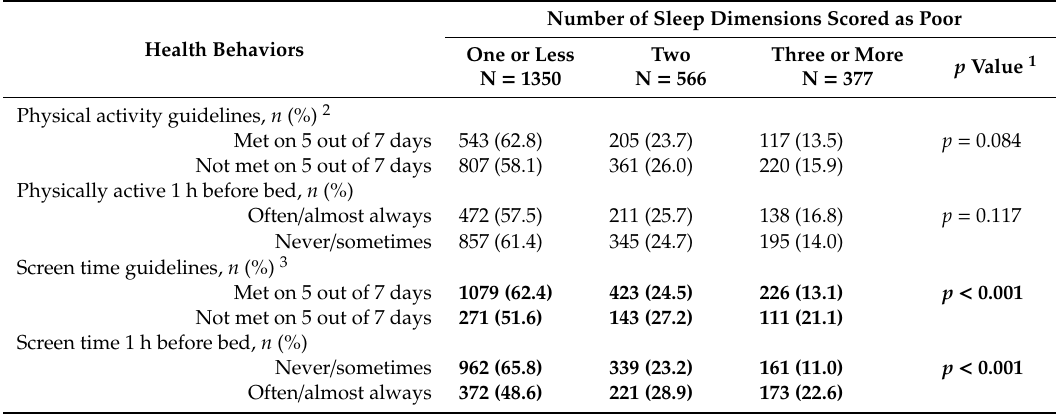
Table 2. Health behavioral characteristics by sleep